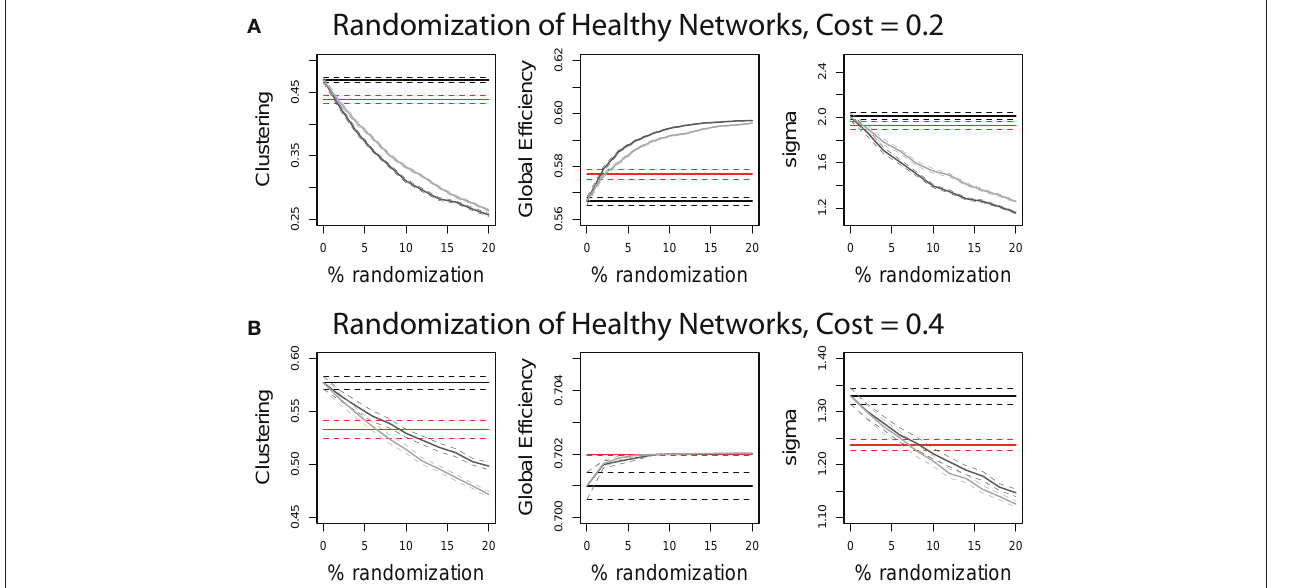
global efficiency and small-worldness (sigma). The gray curves show the effect on these network properties of randomizing the control networks: The light gray curves result if the edges are rewired completely at random, whereas the dark gray curves result if the edges are rewired so as to preserve the degree distribution of the original graphs. See Section “Materials and Methods” for explanations of the network measures and the randomization